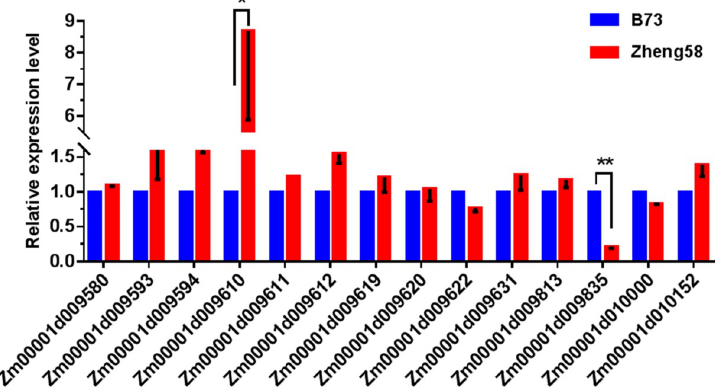
Fig 6. The expression levels of the candidate gene on qLA08-01 loci in the two parents., B73 and Zheng58. The expression level of each candidate gene in B73 is set to 1. The data is the mean ± SD (n = 3). P < 0.05 (Student’s t-test).